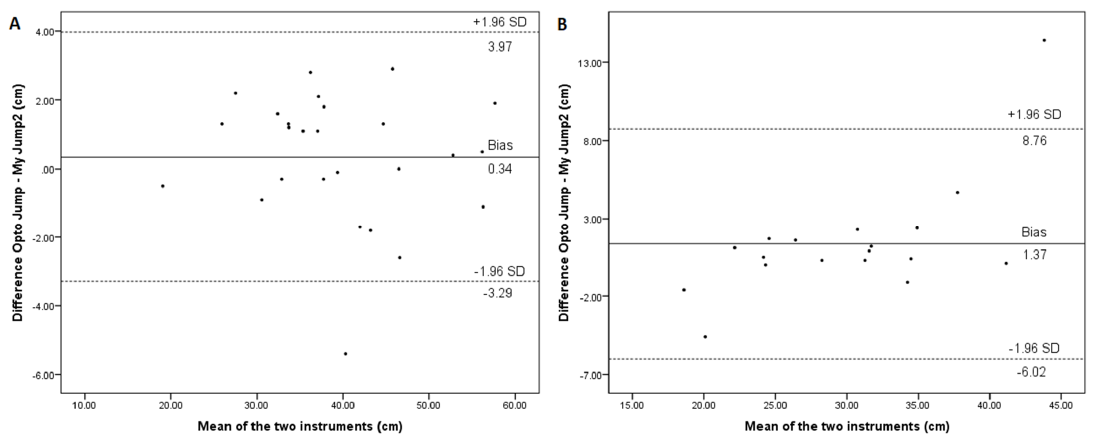
Figure 3. Level of agreement (Bland–Altman) with 95% limits of agreement (dashed lines) and the mean difference (solid line) between My Jump 2 and the Optojump for CMJ in ( A ) male and ( B ) female participants.